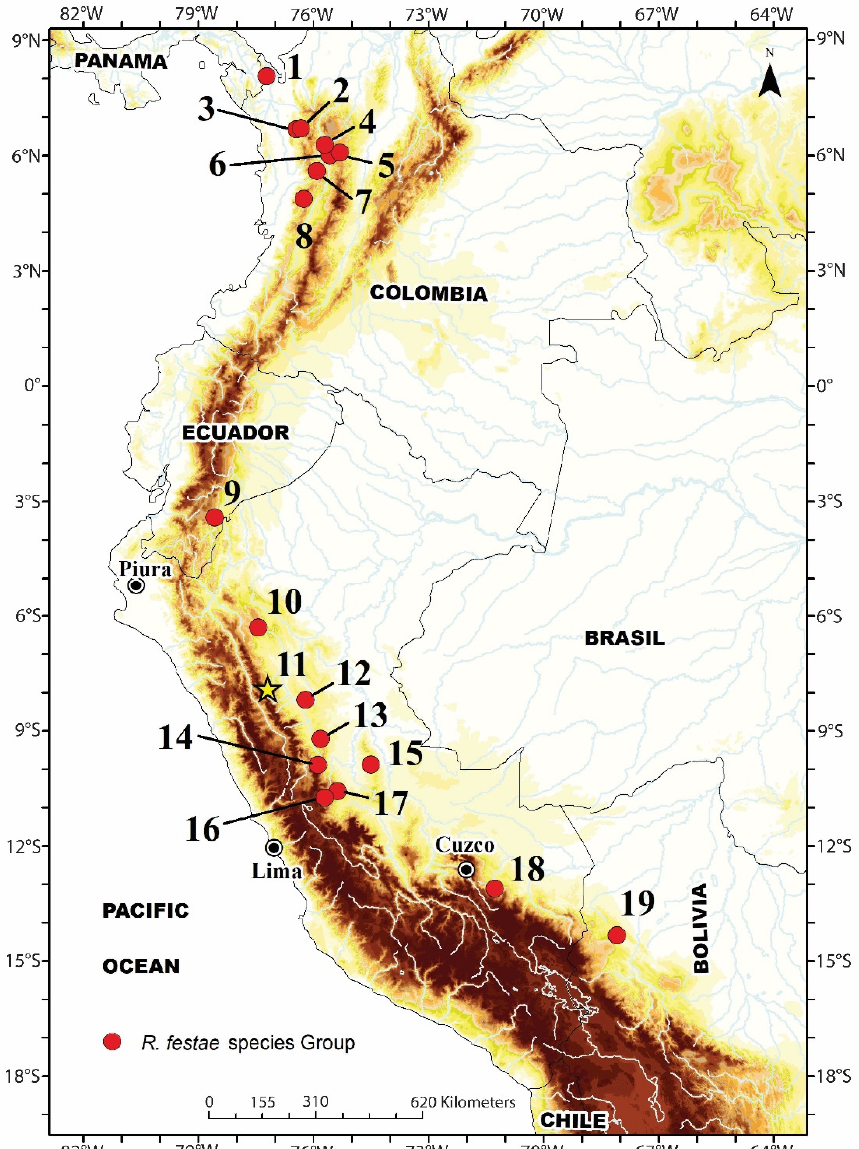
Figure 1. Map indicating type localities (except for R. truebae ) of the members of the Rhinella festae species Group. The yellow star indicates the new species. 1. R. acrolopha , 2. R. lindae , 3. R. tenrec , 4.